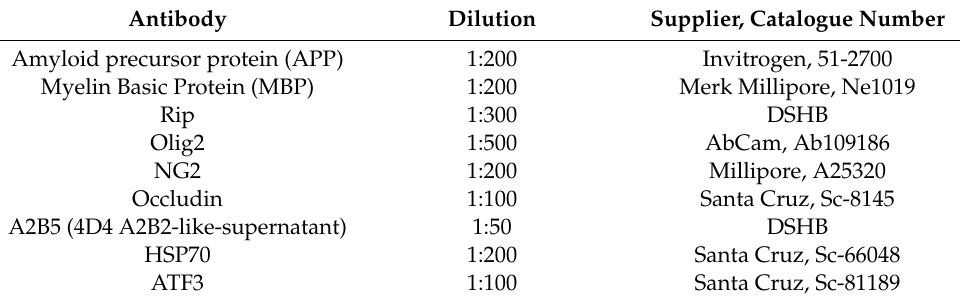
Table 2. List of primary antibodies used in the study.